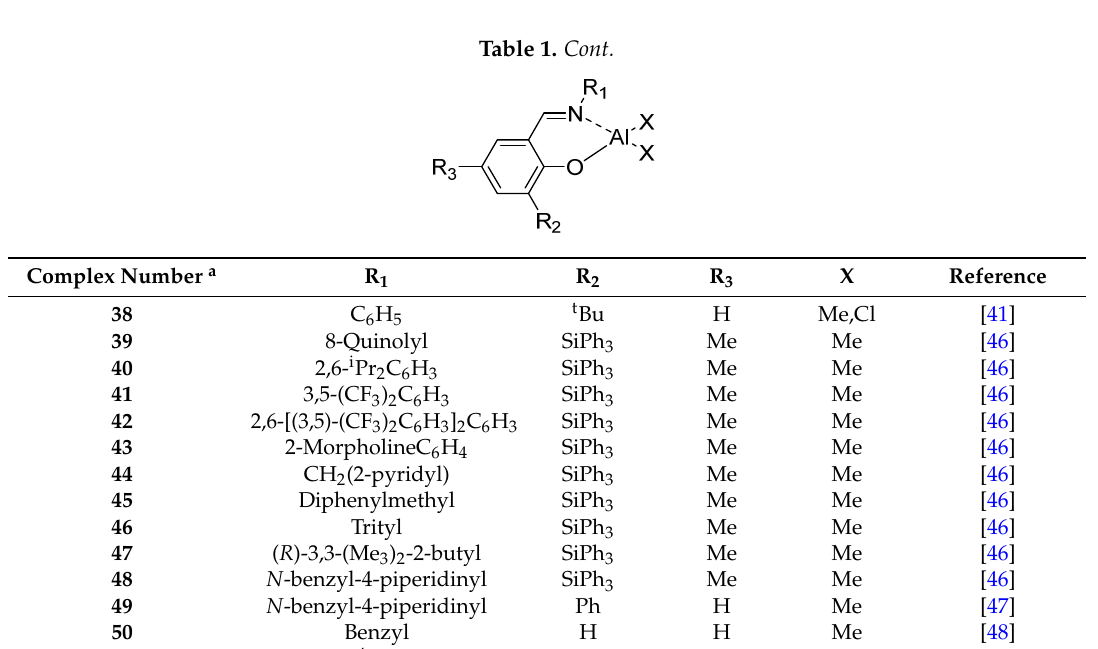
Table 1. Structural features of the (salicilaldiminato)aluminum complexes used in ring ‐ opening polymerization (ROP) of cyclic Table 1. Cont.